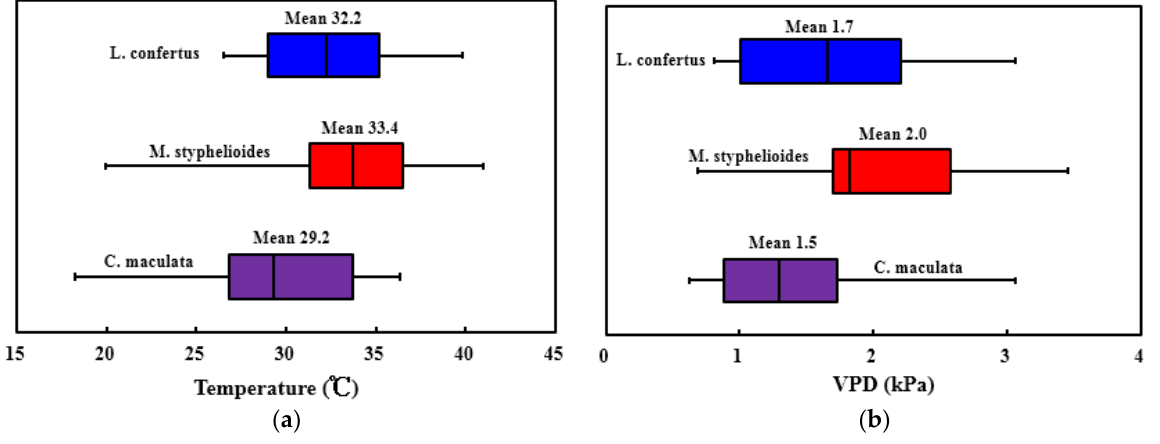
Figure 16. Performance of heat and drought tolerance for the C. maculata , M. styphelioides and L. confertus used in these experiments ( a ) optimal temperature; ( b ) optimal